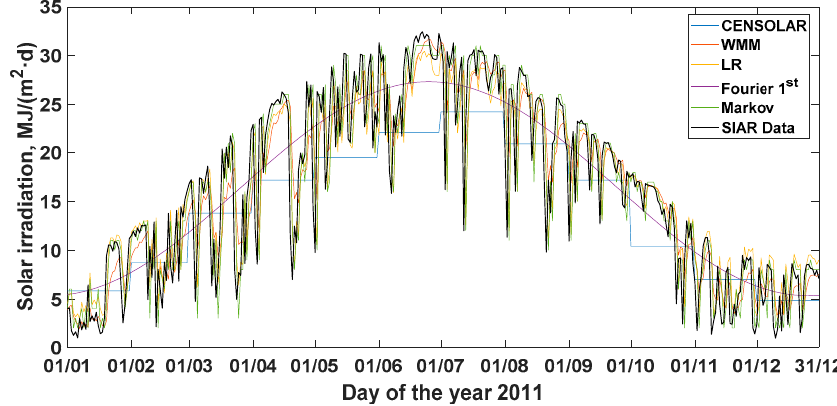
Figure 6. Results corresponding to the horizontal daily global solar irradiation simulation the day after (MJ/(m 2 ·d)), with the classical models evaluated, together with the variable values measured in 2011 (SIAR, agrometeorological station at Mansilla Mayor, León, Spain). CENSOLAR, CENSOLAR typical year; WMM, weighted moving mean; LR, linear regression; Fourier 1st, Fourier analysis with the 1st harmonic; and Markov, Markov analysis. Table 2. Fitting achieved with the evaluated simulation classical models of solar radiation, between the simulated values of the horizontal daily global solar irradiation the day after and the values measured in 2011 at the agrometeorological station in Mansilla Mayor (León, Spain).